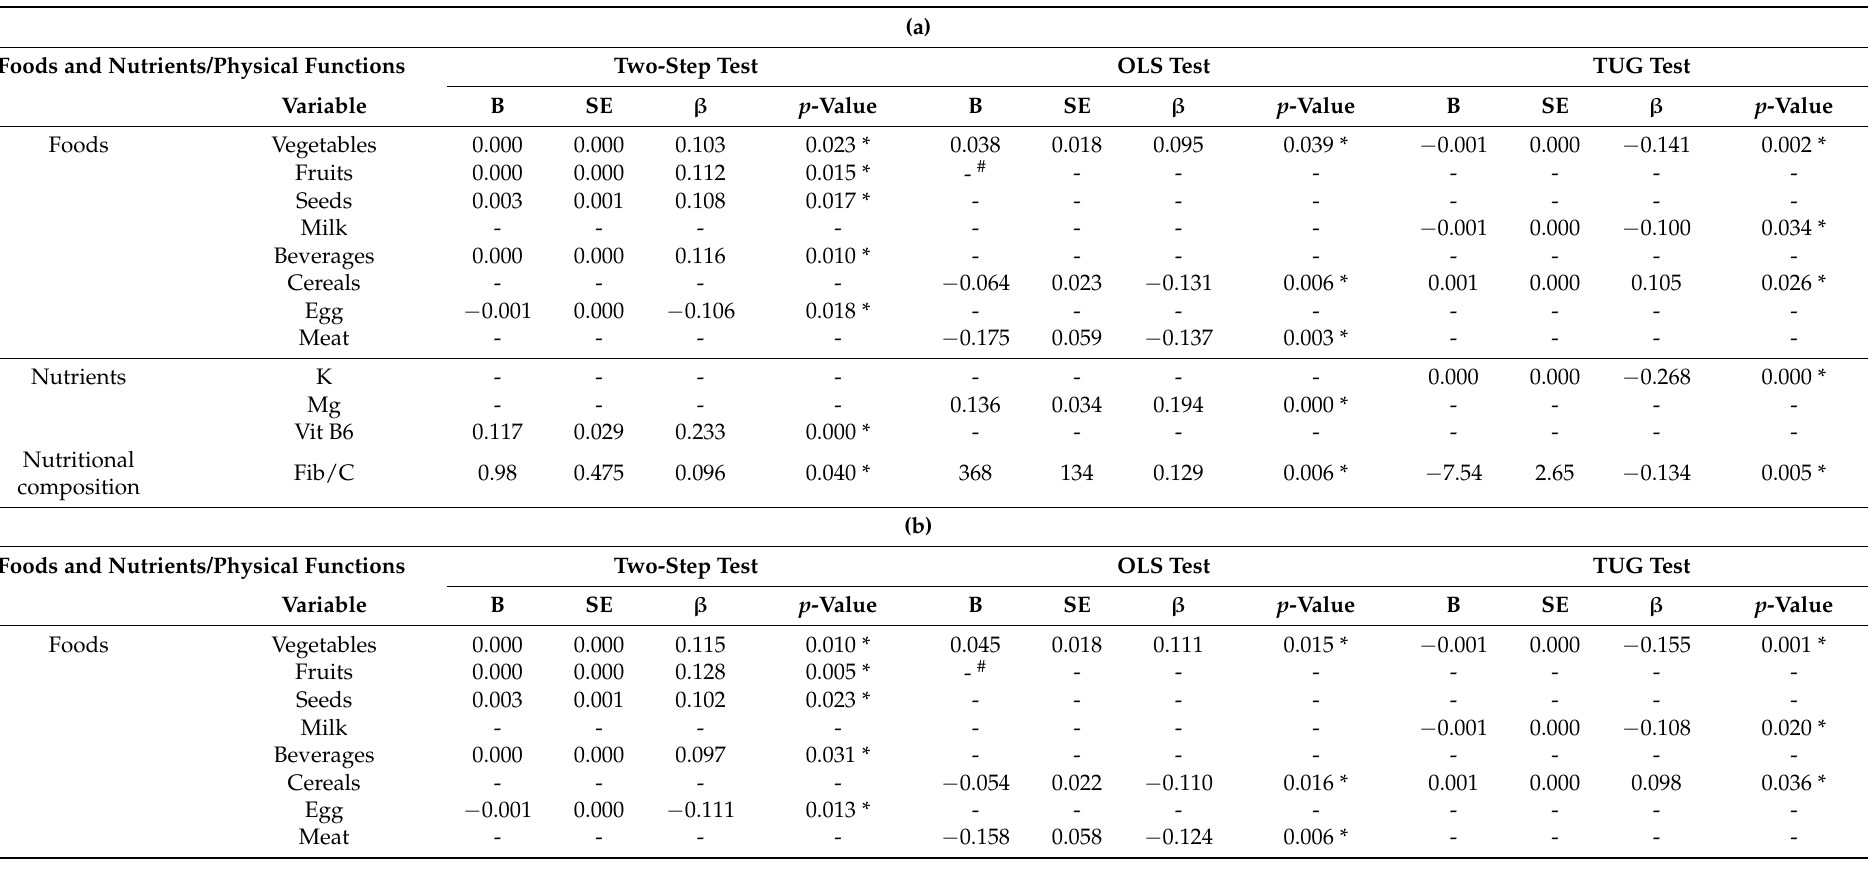
Table 4. ( a ) Results from multiple linear regression models adjusted for sex examining the association of physical functions with food intake 1 . ( b ) Results from multiple linear regression models adjusted for sex and age examining the association of physical functions with food intake 2 . ( c ) Results from multiple linear regression models adjusted for sex, age and body mass index examining the association of physical functions with food intake 3